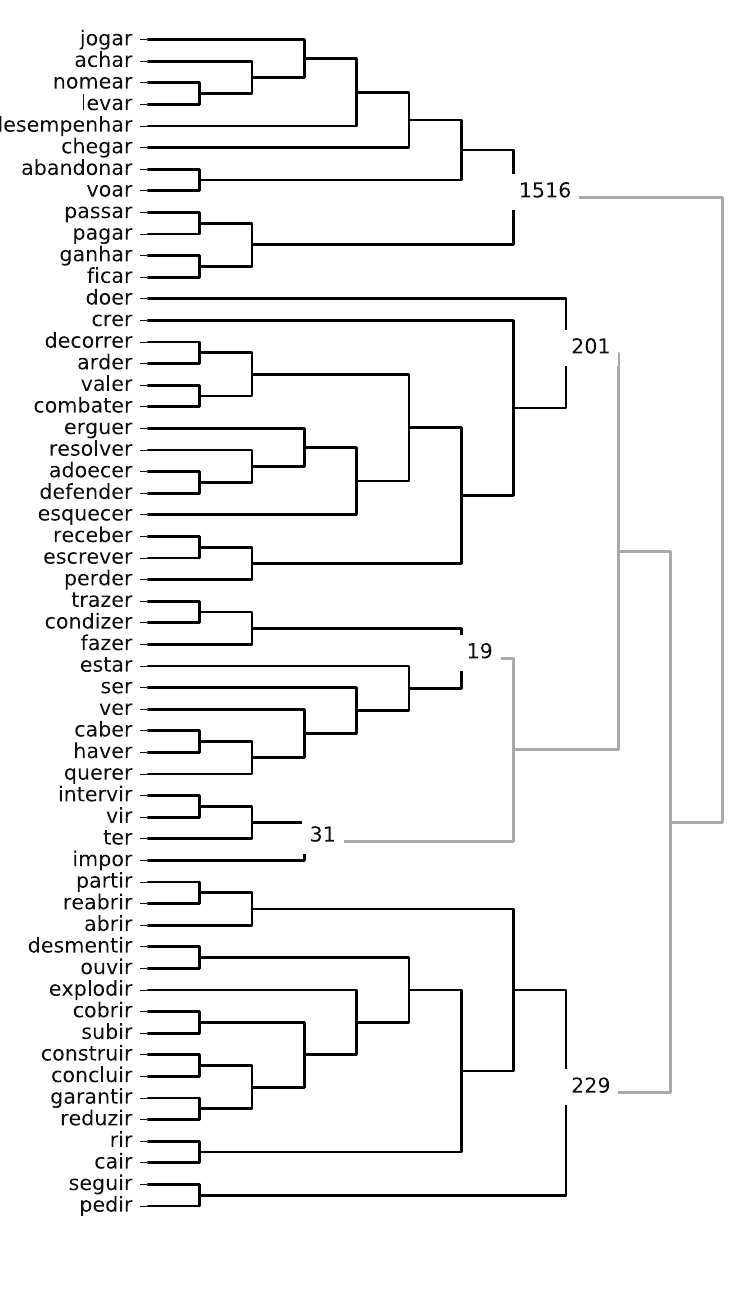
History of merges for